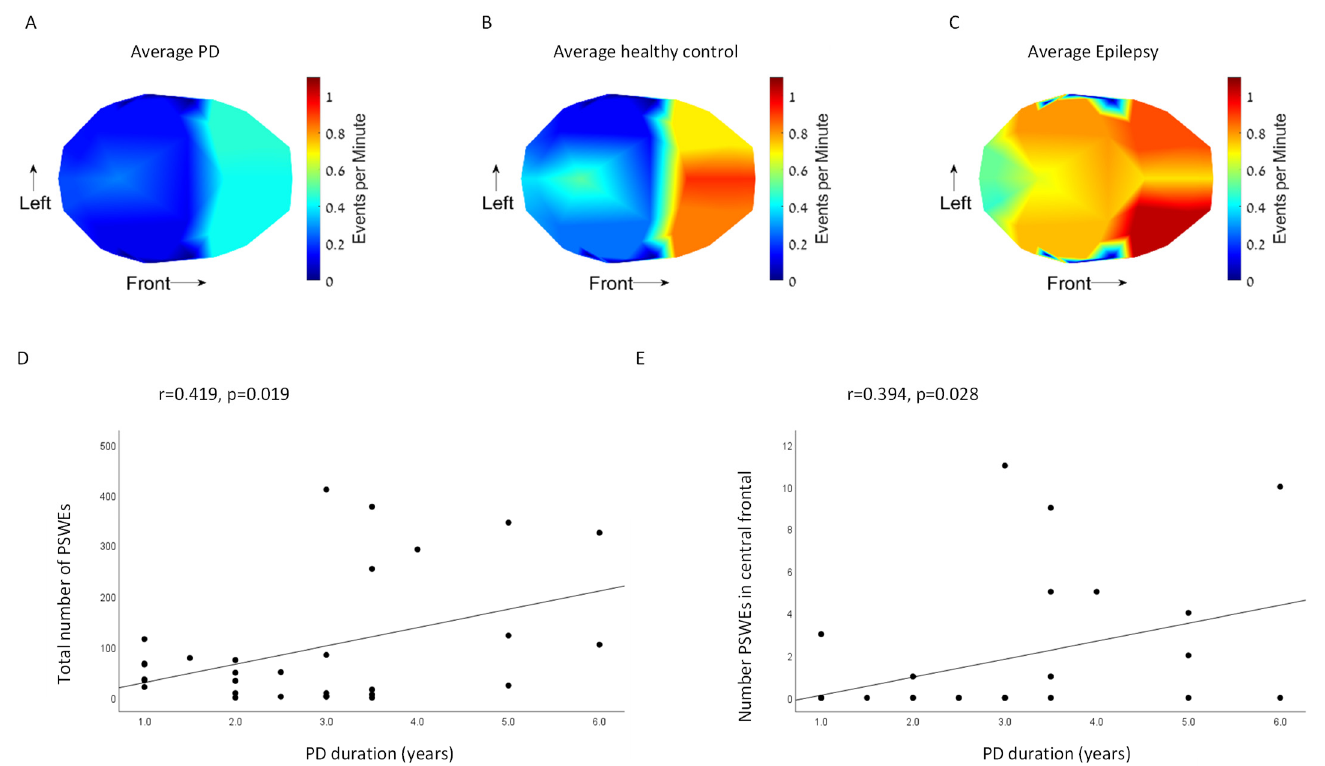
Figure 2. The area under the curve (AUC) of each of the waves for the spectrums in ( A ) Frontal areas, ( B ) Occipital areas, ( C ) Tempo-Parietal areas, and ( D ) Average over all areas. * significant differences.